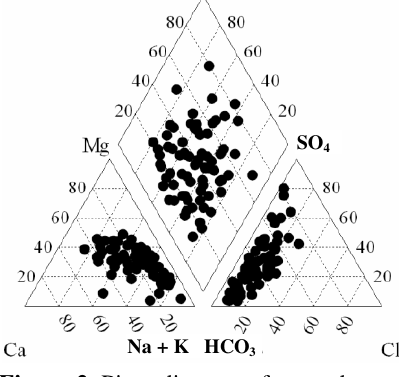
Figure 2. Piper diagram of groundwater